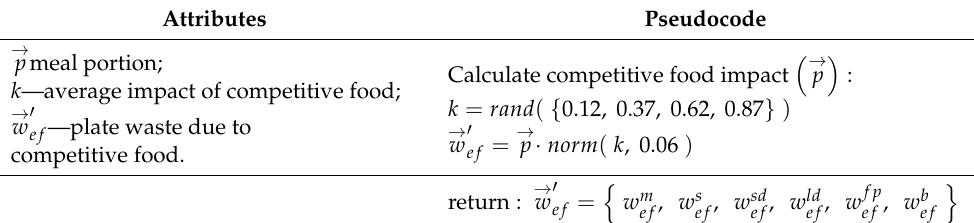
Table 8. Pseudocode for competitive food impact calculation.